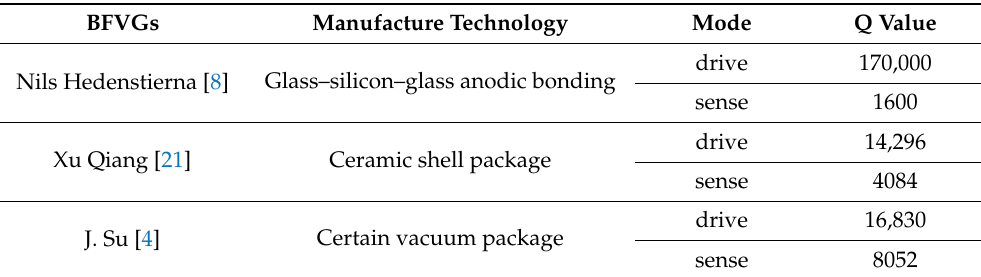
Table 4. The Q factor of BFVGs with different processing.